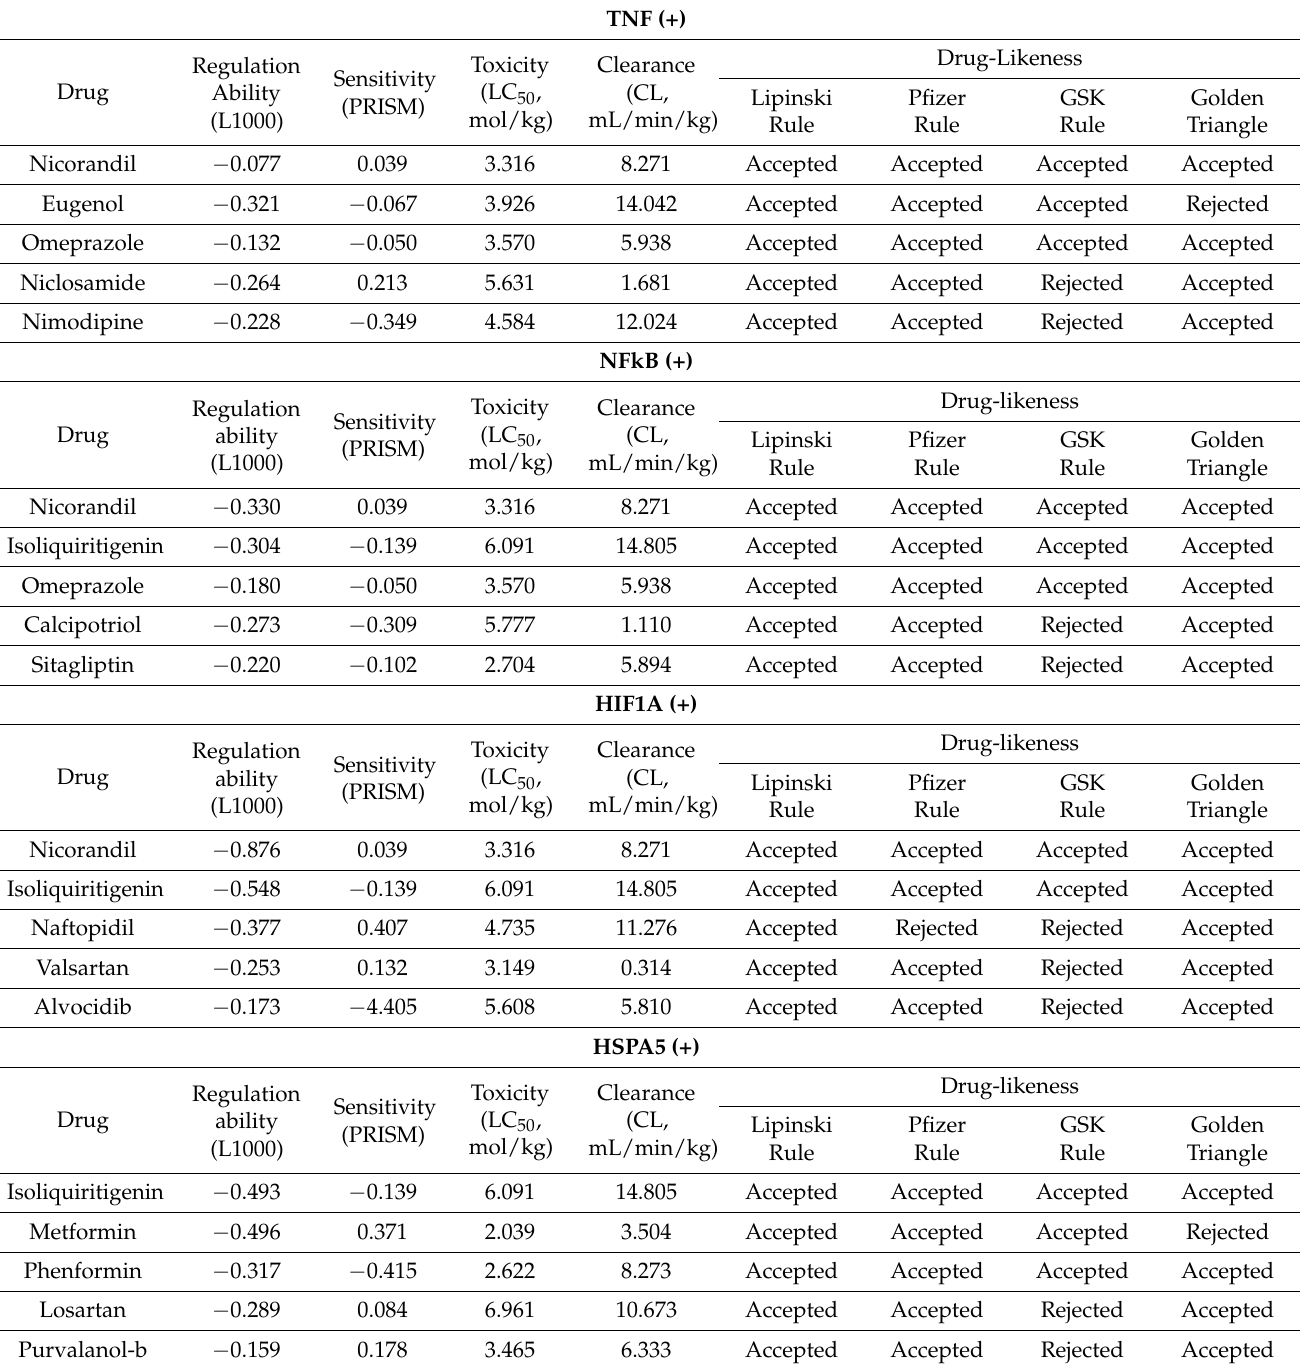
Table 4. Potential small molecule compounds selected for each identified biomarker based on the drug design